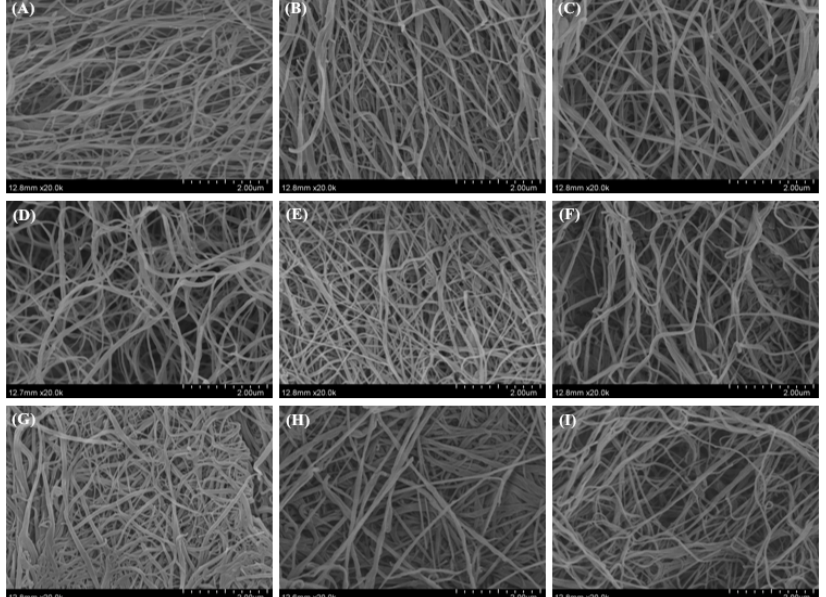
Figure 8. Morphological observation of C. idella skin collagen (SC) fibrils under different salinity and pH: ( A – C ) collagen with NaCl concentration of 0, 140, and 280 mM and pH 6; ( D – F ) collagen with NaCl concentration of 0, 140, and 280 mM and pH 7; ( G – I ) collagen with NaCl concentration of 0, 140, and 280 mM and pH 8. Scale bars, 2 μm.